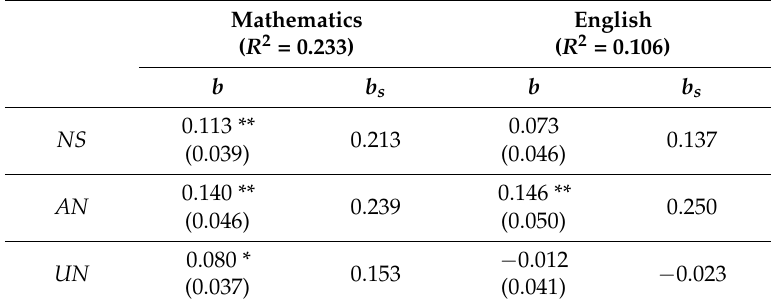
Table 5. Multivariate Regression Analyses with Mathematics and English Grades as Dependent Variables and the Three Intelligence Factors as Independent